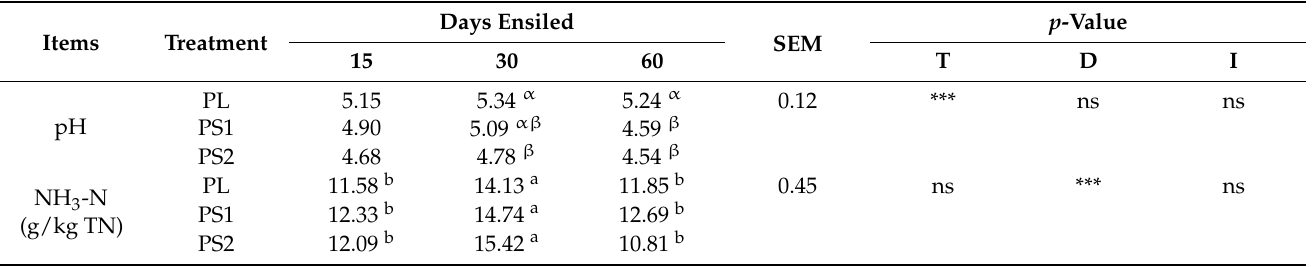
Table 2. pH and NH 3 -N content of different kudzu